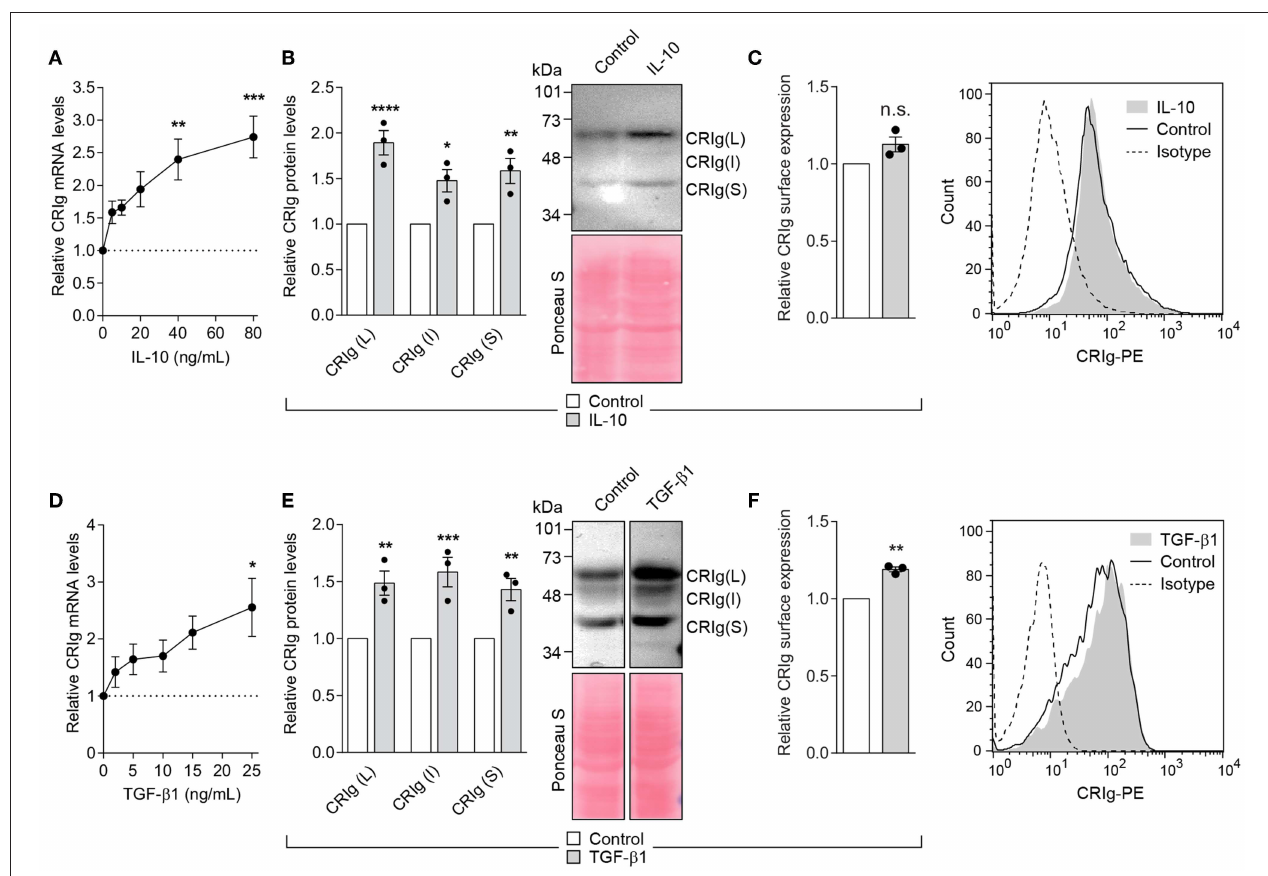
FIGURE 5 | IL-10 and TGF- β 1 increase CRIg expression in DC. (A,D) DC were treated with varying concentrations of the cytokines for 24h and then examined for CRIg mRNA expression. DC were treated with either 40ng/ml of IL-10 or 25ng/ml of TGF- β 1 and CRIg isoform protein expression in DC lysates (B,E) or CRIg expression on the cell surface (C,F) were measured. Data are presented as means ± SEM of three experiments, each conducted with cells from different individuals. The blot image in (E) was spliced to exclude intervening lanes that represent other treatments and the complete un-spliced blot can be found in Supplementary Figure 2 . Significance levels are indicated by asterisks: * P < 0.05, ** P < 0.01, *** P < 0.001, **** P < 0.0001, whilst n.s. indicates